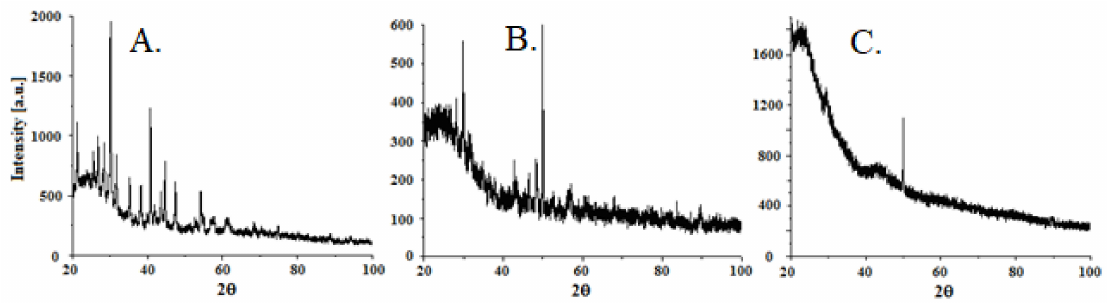
Figure 6. XRD patterns of the samples: A —Ni-CMC, B —Co-CMC, and C —Fe-CMC.